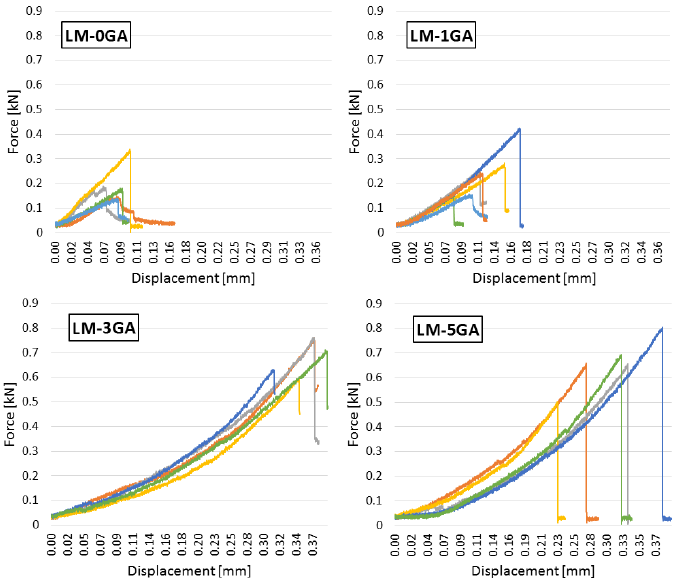
Figure 8. The dependence of the bending force on the displacement of the press head. The relationship between the stress and the strain of all samples within an individual recipe is shown in Figure 9. Figure 9. The dependence of the bending force on the displacement of the press head.